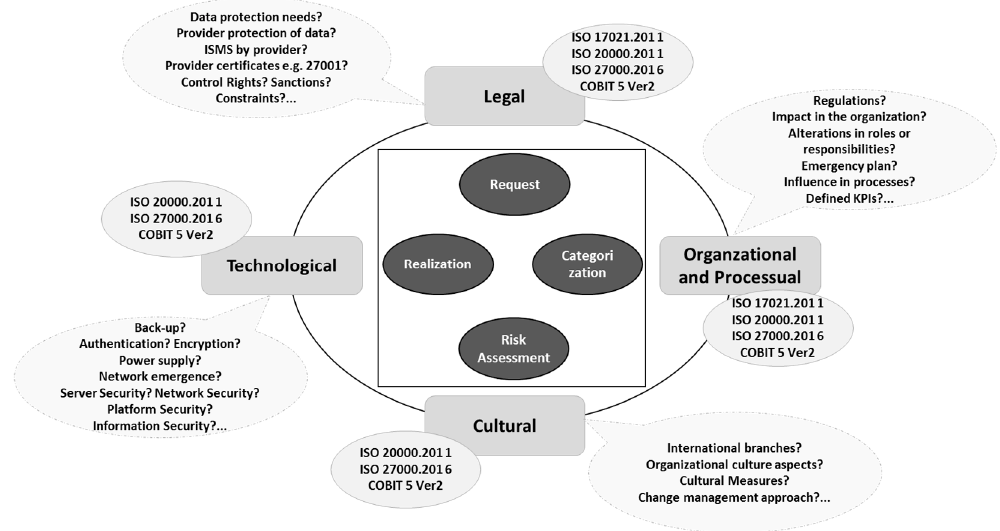
Figure 1. Overview of the main aspects of the developed framework, including the influences of standards to each aspect and features to consider.